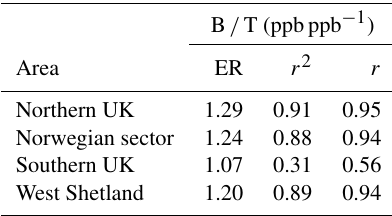
Table A3. Benzene to toluene emission ratios (ERs) for each sampling region along with corresponding r 2 values and Pearson correlation coefficients ( r